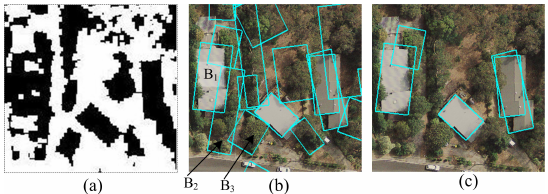
Figure 5: A complex scene: (a) primary mask, (b) detected can- didate buildings with a large number of false detections and (c) detected final buildings after removing false